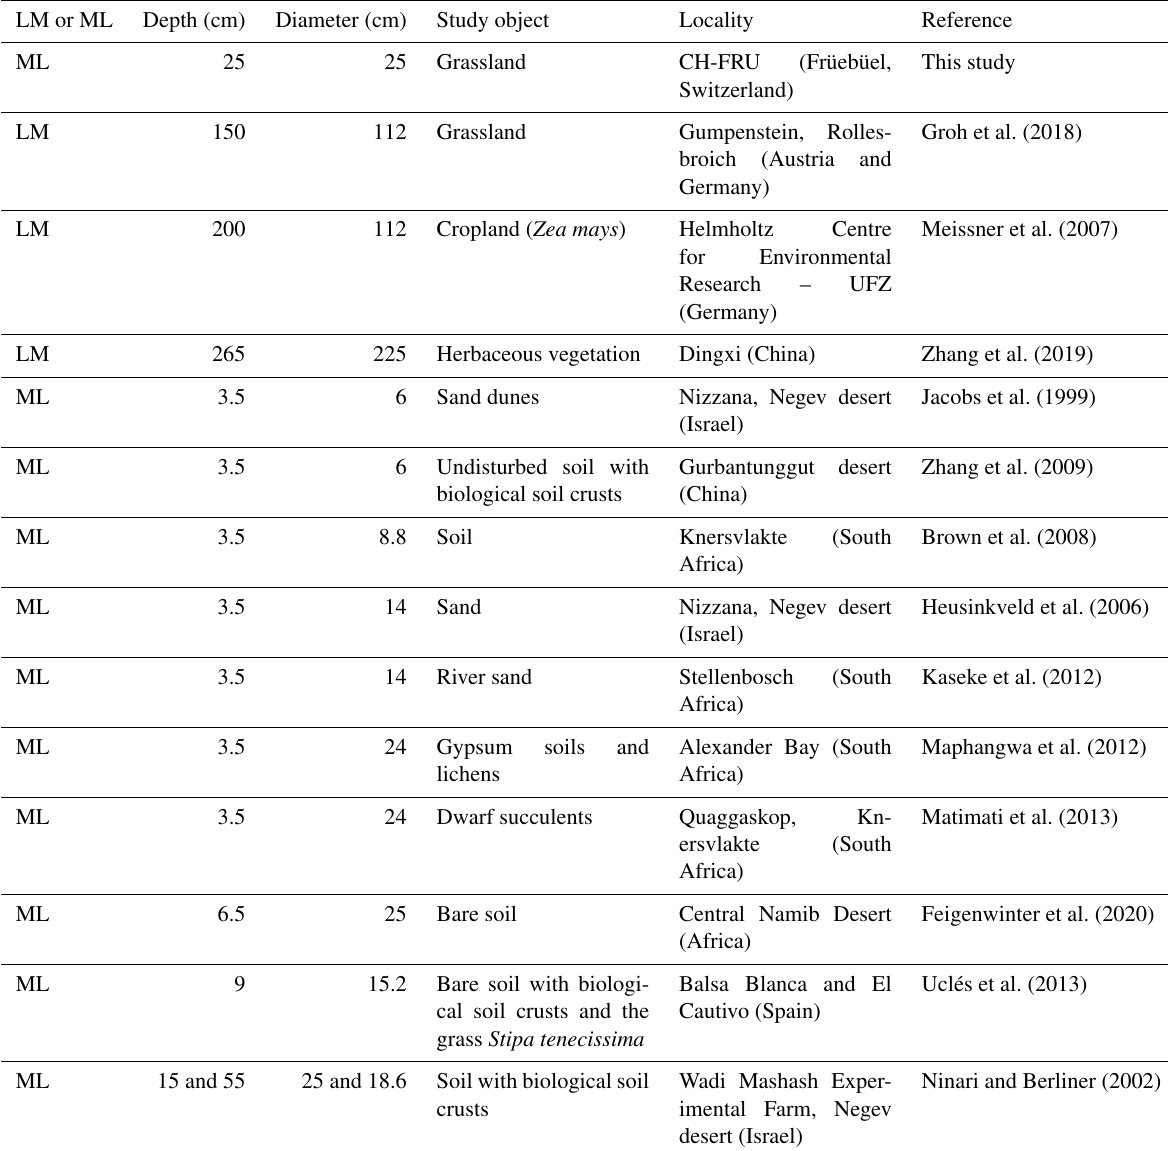
Table 4. Size comparison of LMs and MLs developed and used for NRW studies. LM or